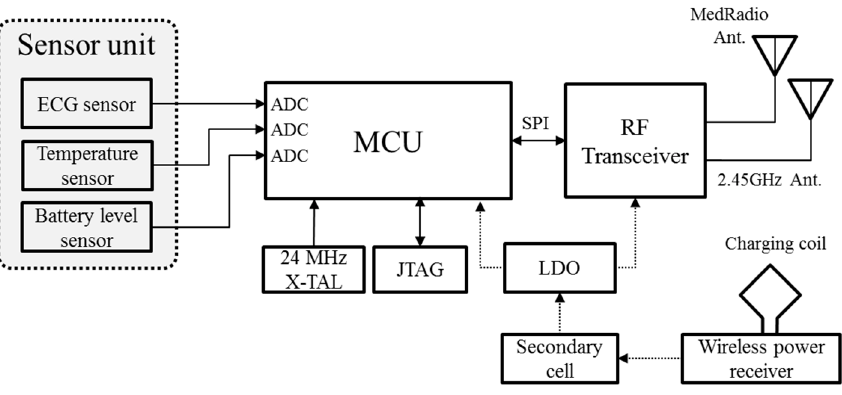
Figure 11. Block diagram of the SoB.